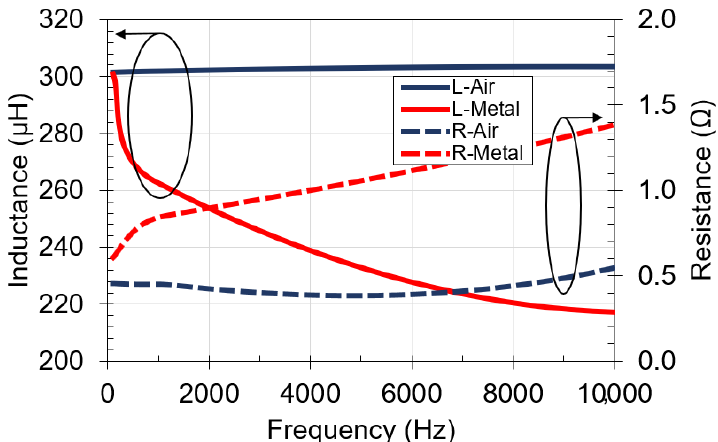
Figure 2. Measured inductance and resistance versus frequency for coil on: air and 1 mm-thick aluminum plate.